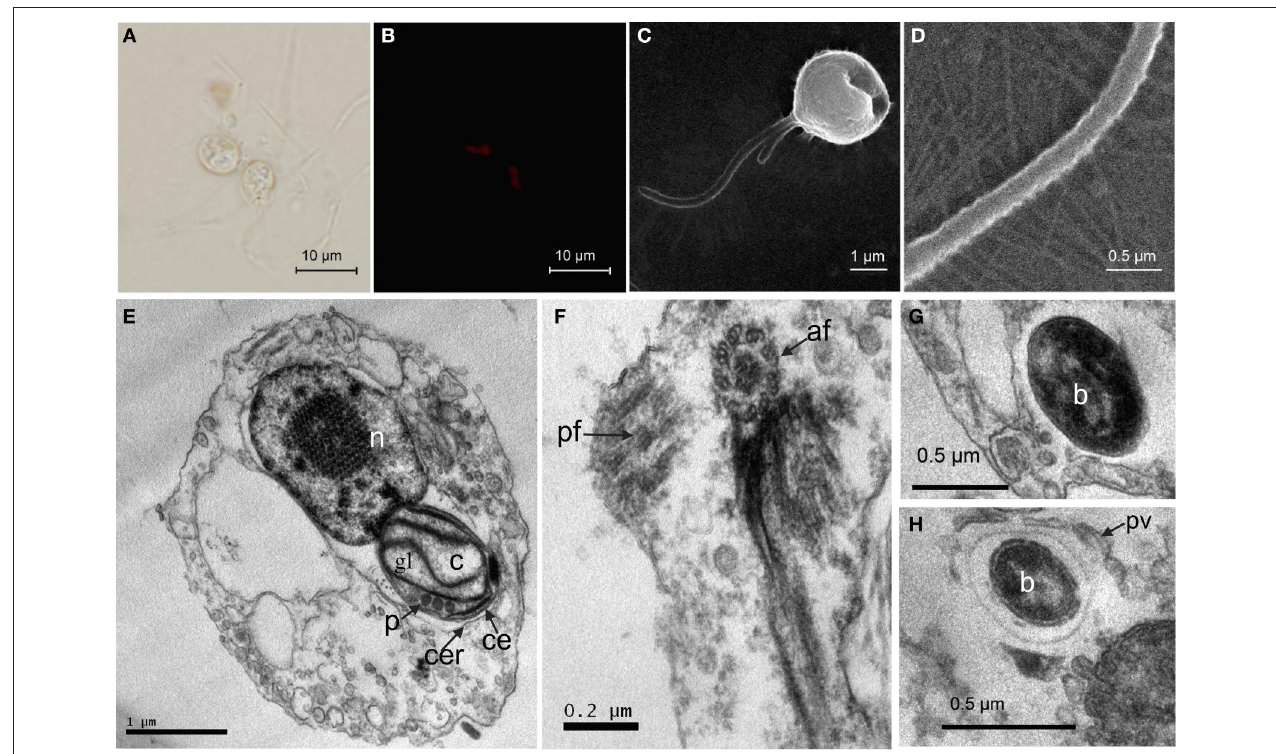
FIGURE 1 | Morphology and ultrastructure of the flagellate. (A) Bright-field image of the flagellate; (B) Autofluorescence of a chloroplast under the fluorescence microscopy; (C) SEM image showing the anterior flagellum (AF) and the posterior flagellum (PF); (D) High magnification view of the mastigoneme bearing AF; (E) Flagellate cell containing a single nucleus (n), a chloroplast (c). The chloroplast (c) is surrounded by the chloroplast endoplasmic reticulum (cer), which is connected to the nuclear envelope. The girdle lamella (gl) lies parallel to the double layers of the chloroplasts envelope (ce), and three pigment granules (p) are within the chloroplast; (F) Cross section of a posterior flagellum (pf), anterior flagellum (af); (G) Bacteria (b) within the flagellate. (H) Protoplasmic vesicle (pv) surrounding a bacterium